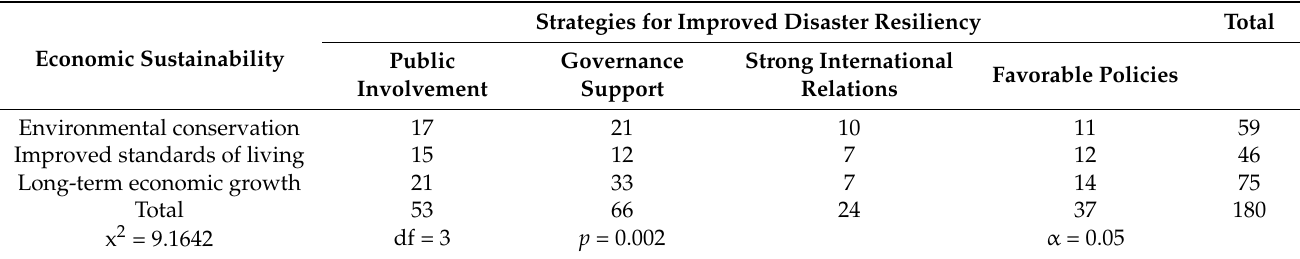
Table 5. Cross-tabulation strategies for improved disaster resiliency and economic sustainability.